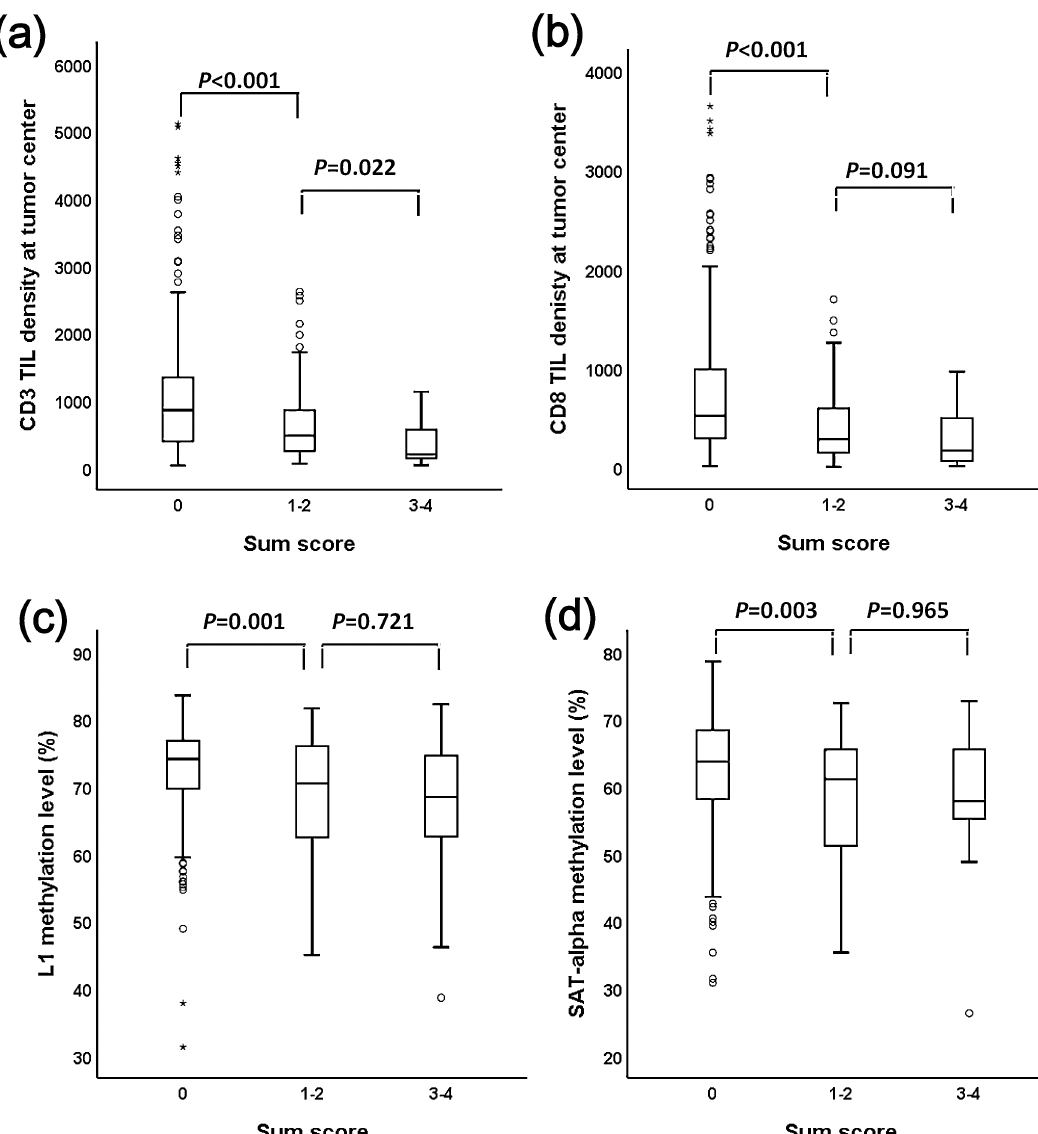
Figure 3. Density of tumor-infiltrating lymphocytes and methylation levels of repetitive DNA elements in gastric carcinomas according to sum score. ( a , b ) CD3 and CD8 tumor-infiltrating lymphocyte densities and ( c , d ) L1 and SAT-alpha methylaiton